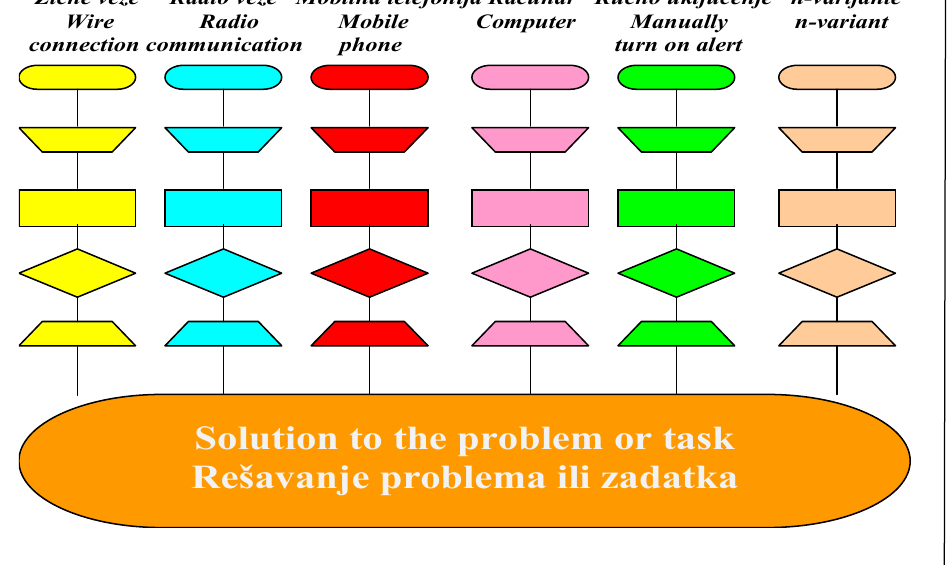
Figure 2 – Heuristic algorithm for problem/task